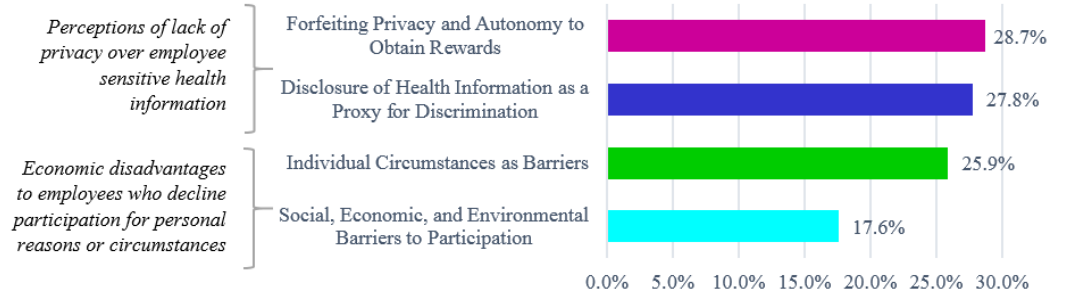
Figure 2. Stakeholder concerns about discrimination in employer-sponsored wellness programs